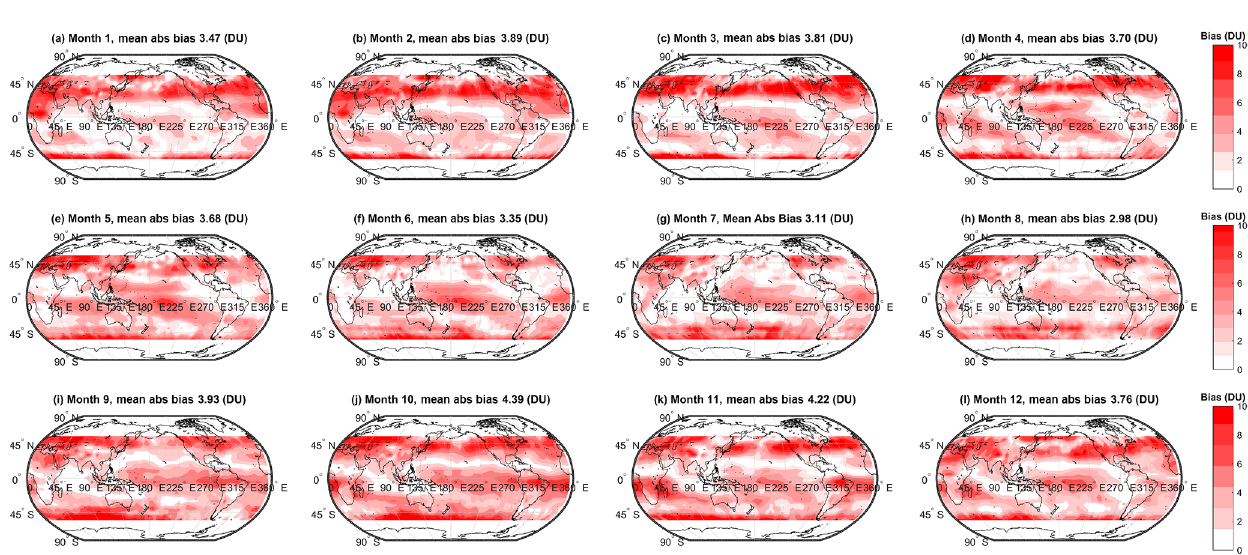
Figure 4. As Fig. 3 but for the cluster-based MMM.